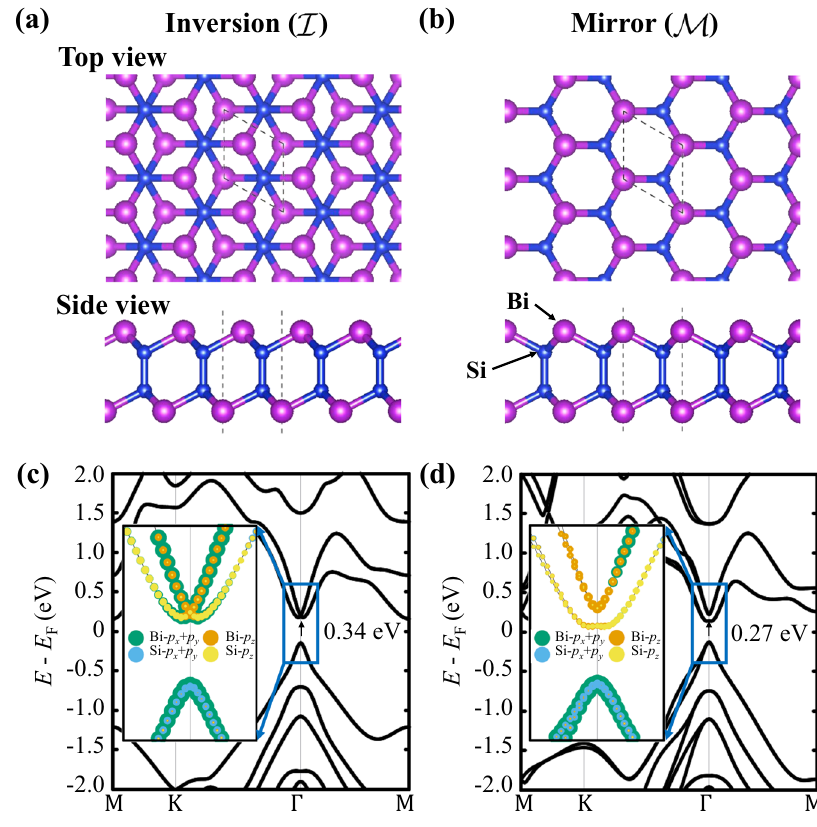
Fig. 1 Crystal and electronic structures of I and M -Si 2 Bi 2 . Top and side views of the equilibrium crystal structures of Si 2 Bi 2 , where Si and Bi atoms are depicted by yellow and purple balls for two different phases with: a inversion ( I ) and b mirror ( M ) symmetries, and c, d their respective electronic band structures, of which the orbital-resolved conduction and valence bands near the Γ point are shown in insets, where each color is assigned to each projected orbital and the line thickness indicates the degree of the orbital contribution. The calculated band gap values at the Γ point are 0.27 and 0.34 eV,